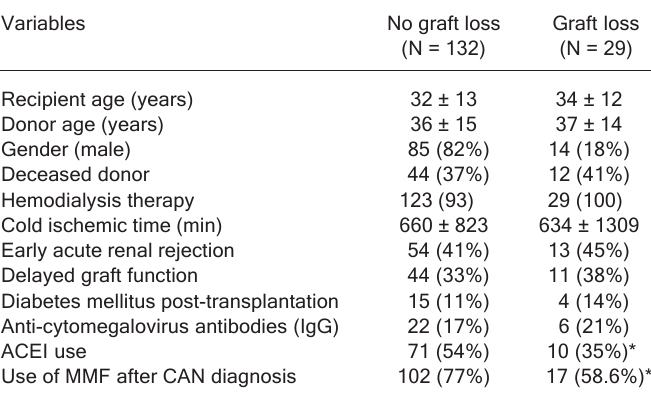
Table 4. Univariate analyses of patients with graft loss.